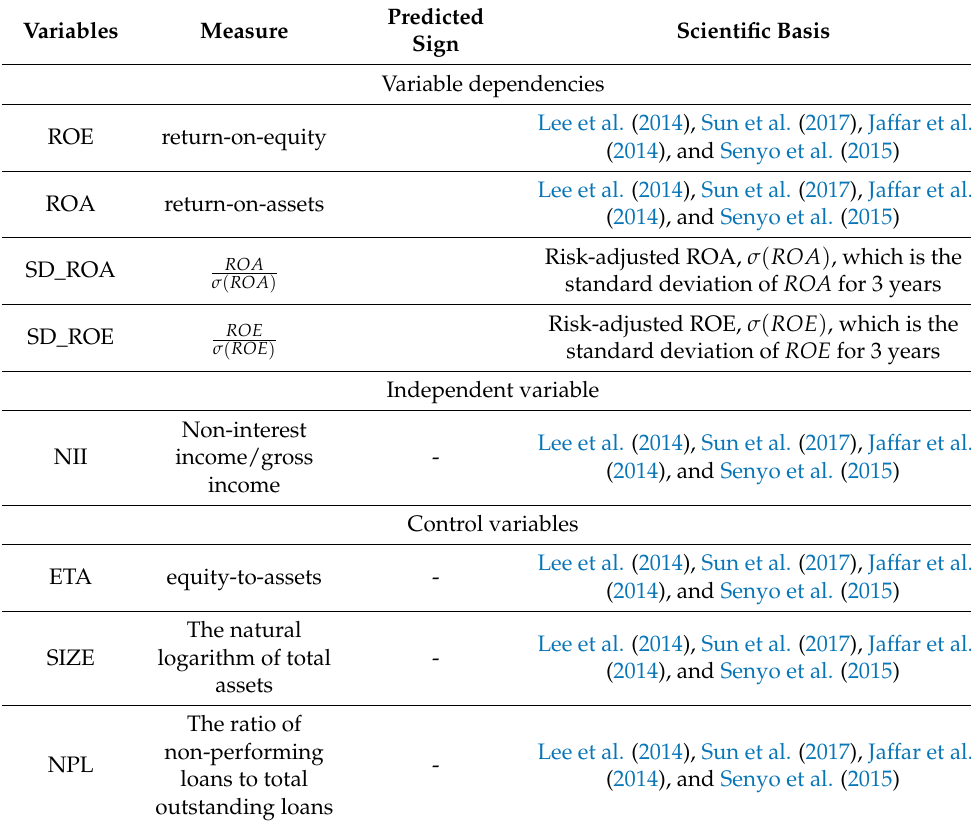
Table 1. Definition of